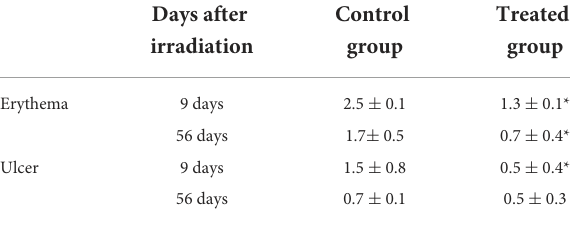
TABLE 4 Macropathological score of RIOM.